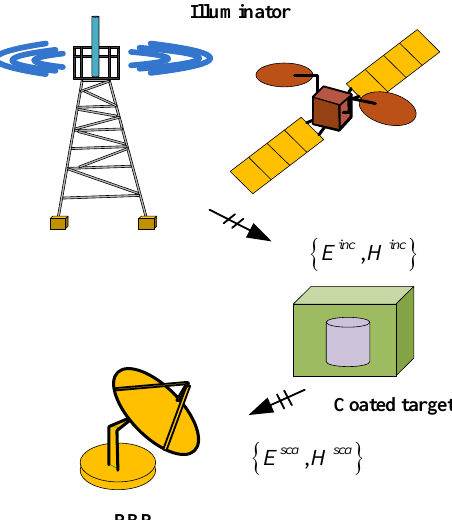
Figure 1. Illustration of the passive bistatic radar system based on a non-cooperative illuminator.